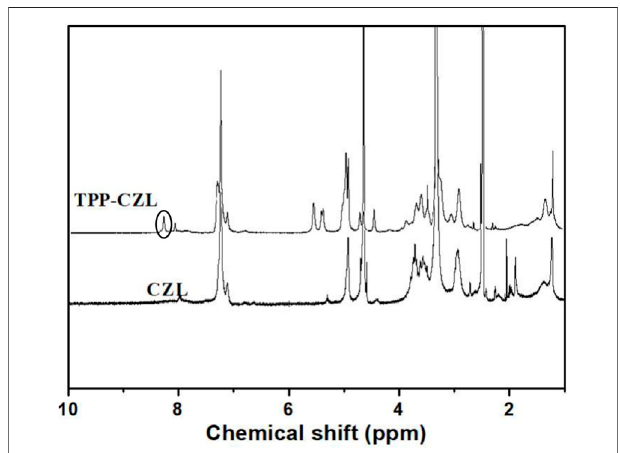
FIGURE 1 | 1 H NMR spectra of CZL and